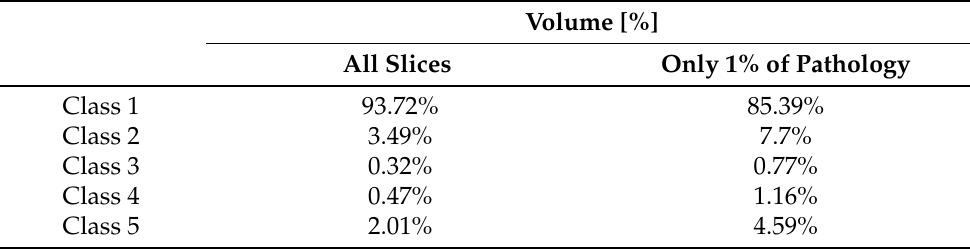
Figure 1. Examples of scans representing all classes and corresponding label maps. Table 1. The distribution of the label classes in the development dataset when all slices were used for training and when only slices where at least 1% of pathology (Classes 2 to 5) was